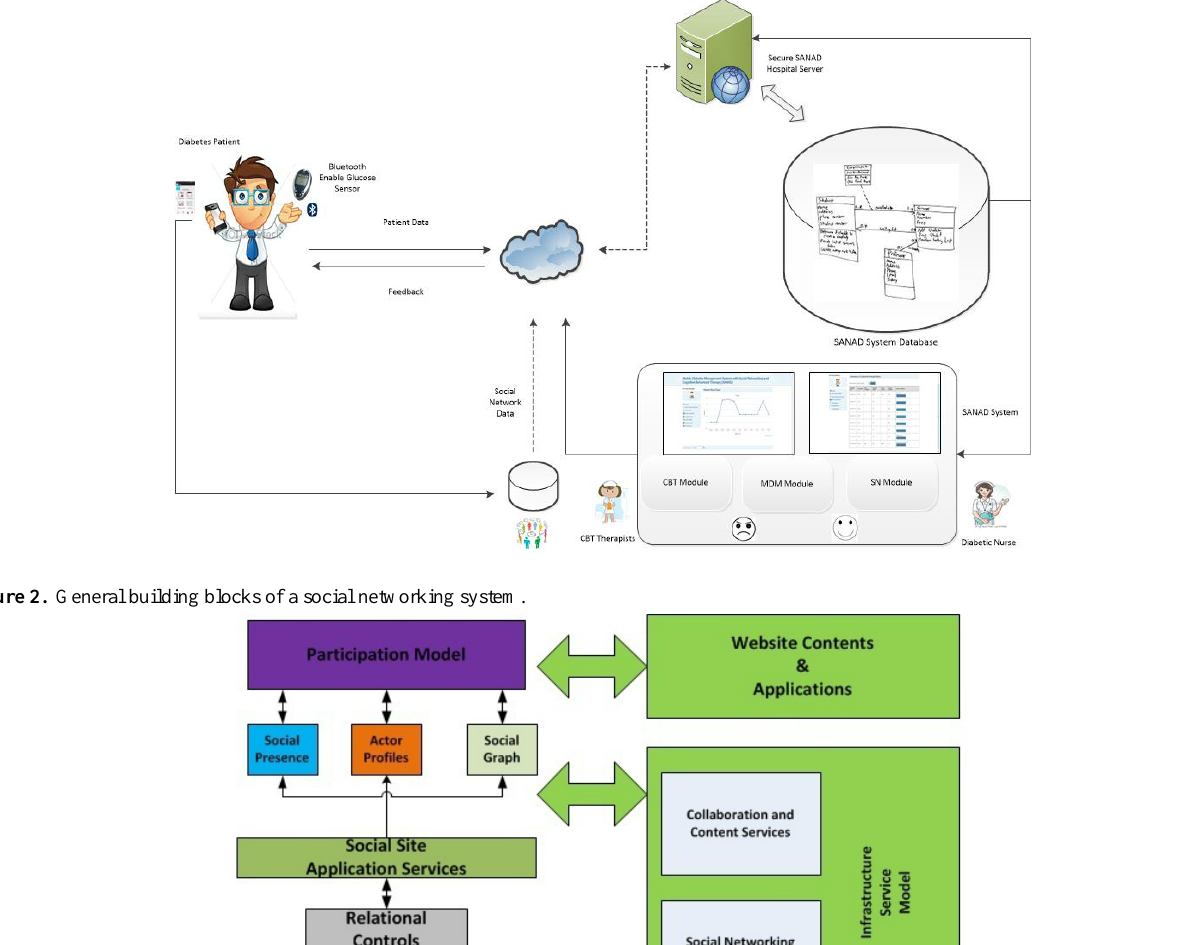
Figure 1. General architecture of the Saudi Arabia Networking for Aiding Diabetes (SANAD) system. CBT: cognitive behavioural therapy; MDM: mobile diabetes management; SN: social networking.